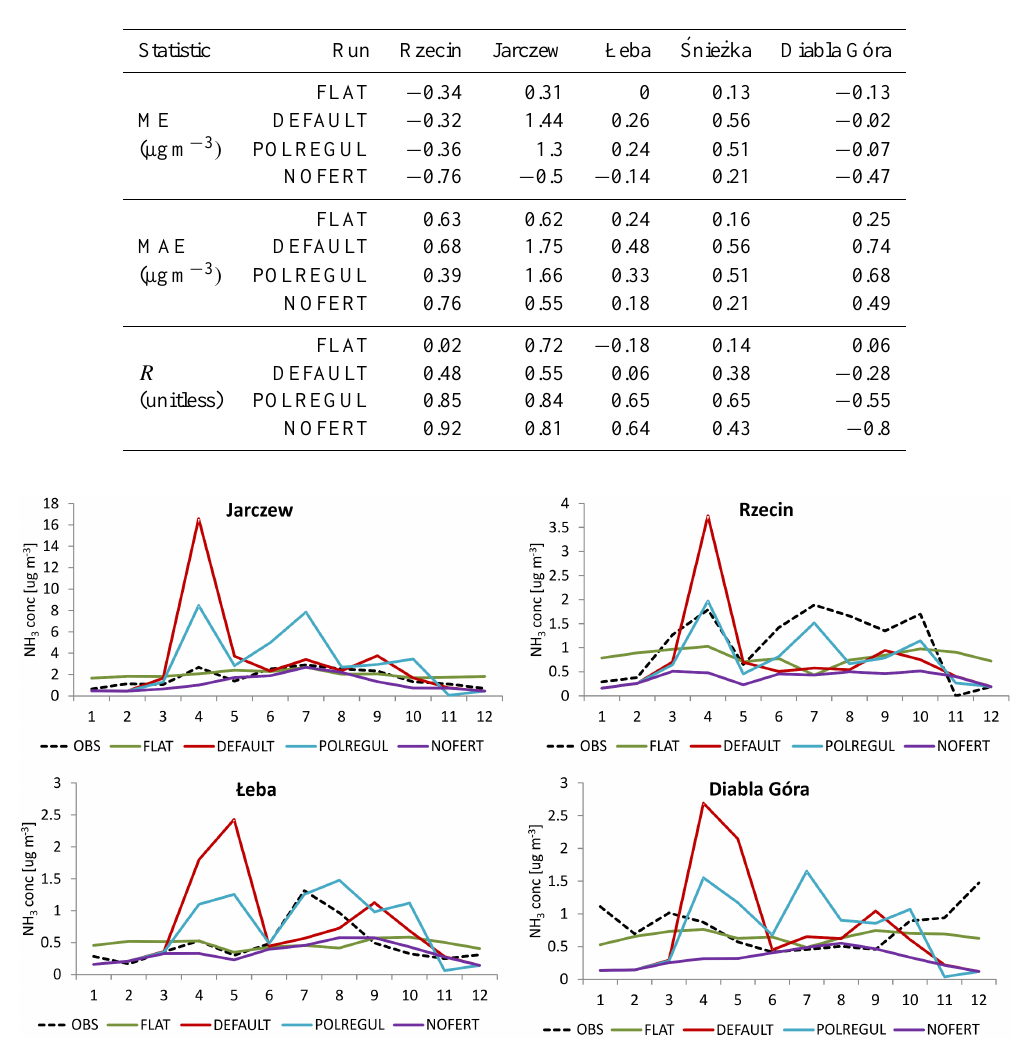
Table 5. FRAME model results – error statistics for the individual sites (mean from 12 months).